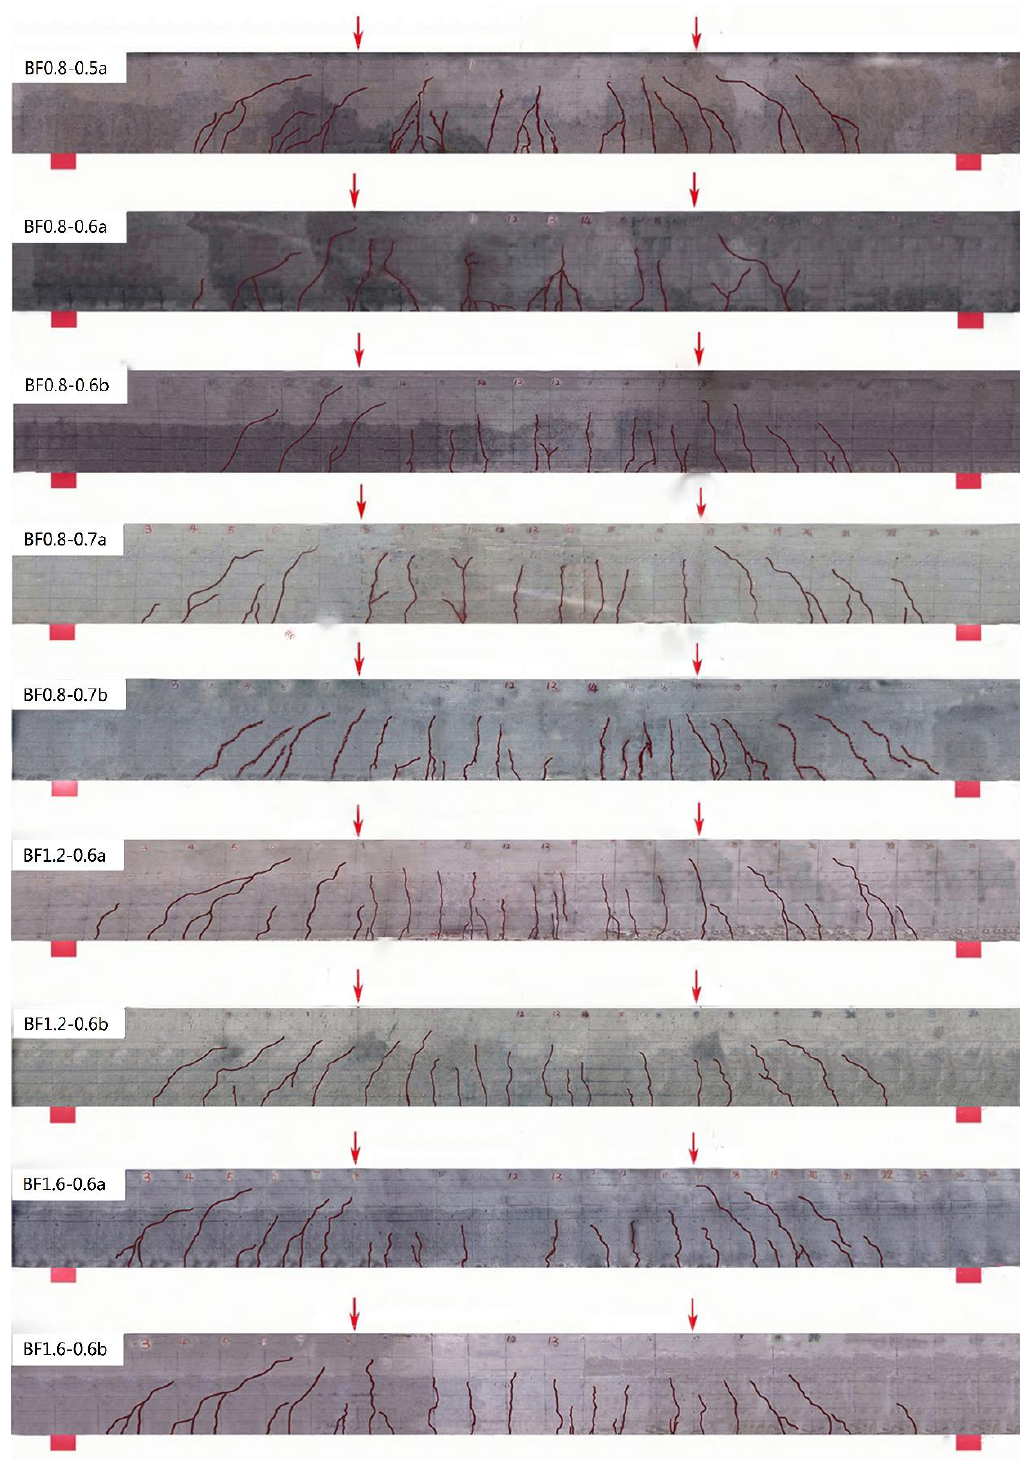
Figure 3. Crack distribution of test beams with different α h or v f .